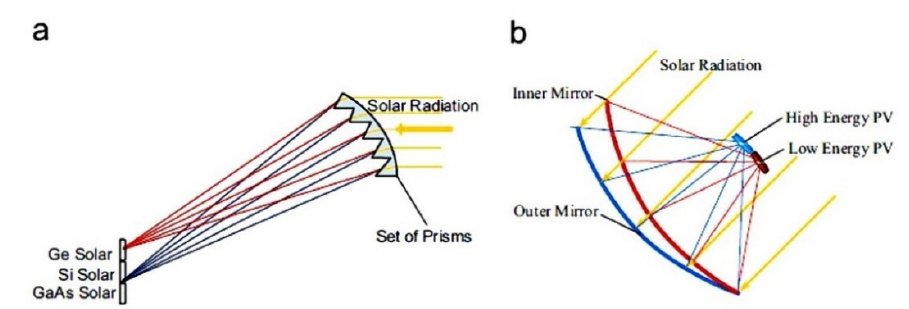
Figure 3. Device of concentrating and splitting the spectral light into a single stage [14]. ( a ) A concentrating PV system with spectral separation using a set of prisms; 100 × and 17.5 × concentration levels for monochromatic and polychromatic (between 730 nm and 1000 nm) beams respectively were achieved [45]; ( b ) A concentrating PV system comprising a dish shaped 1 m 2 reflector made of two layers of faceted mirrors to create two focal points 20 cm off each other; Inner mirror reflects wavelengths above 650 nm and transmits below that; the outer mirror reflects all wavelengths [46].